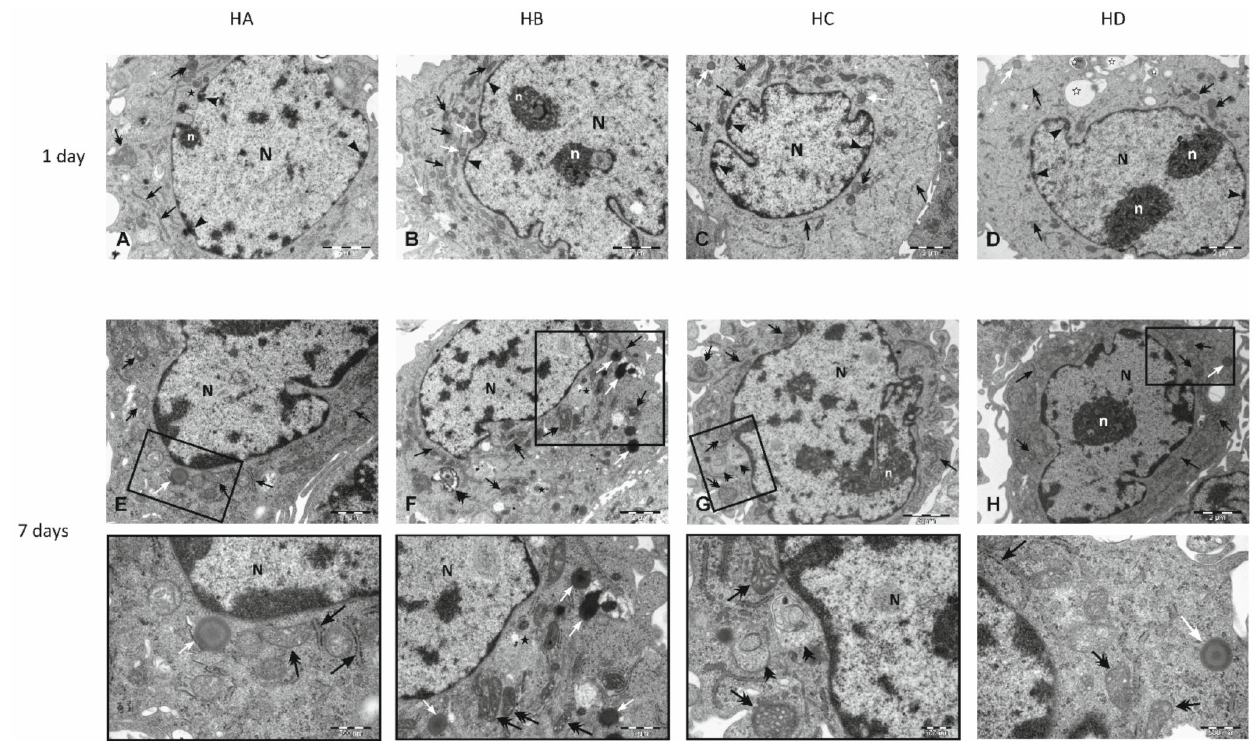
obese patients (group 2) revealed changes in cellular ultrastructure in both time inter- vals (OA—Figure 6C,G; OB—Figure 6D,H). The ultrastructural changes were generally concerned with the (i) accumulation of lipid droplets in the cytoplasm, (ii) changes of mito- chondrial architecture reflected by enlarged intra-cristal spaces and (iii) decreasing amount of rough endoplasmic reticulum (RER) cisterns. In the cytoplasm, autophagic vacuoles were also observed. These changes reflect endothelial metabolic and energetic dysfunction, and ten weeks with flaxseed supplementation did not reverse them. All observed details in electron micrographs are precisely described in Figures 5 and 6.